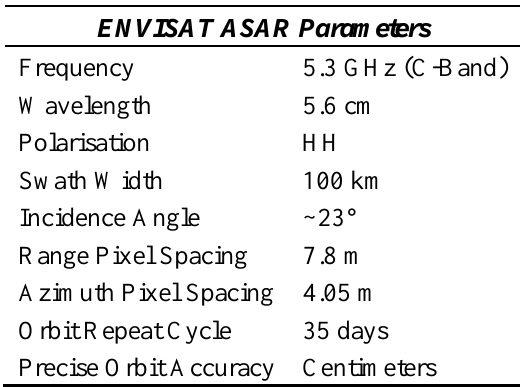
Table 3. Basic characteristics for ENVISAT ASAR data used in the study (Strip Map imaging).